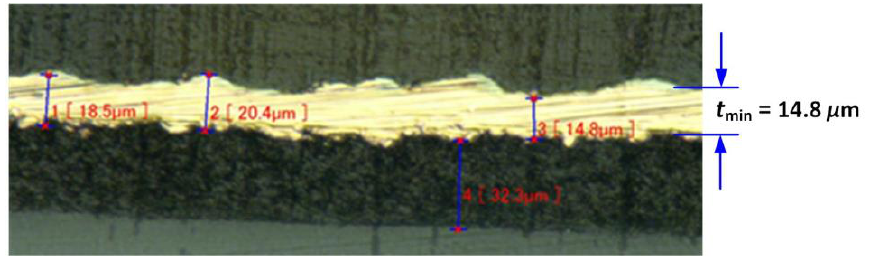
Figure 11. Metallization of the antenna track.